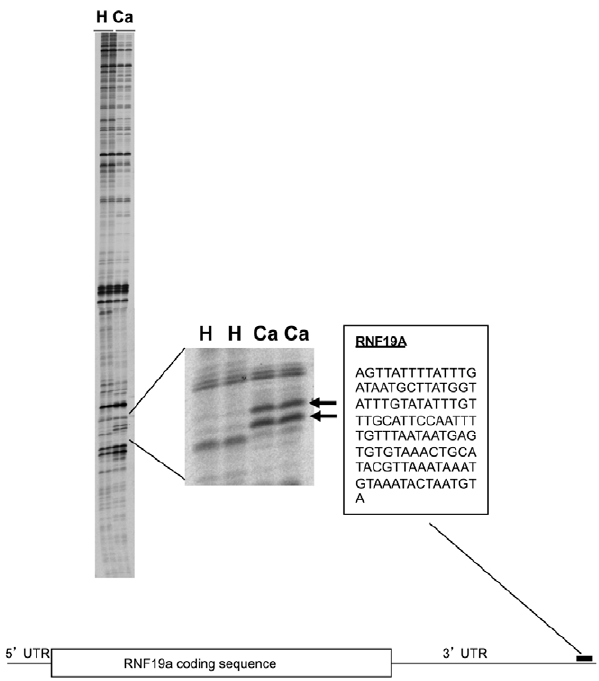
Figure 1. ADE analysis of whole blood RNA from prostate cancer patients vs. healthy men. ADE analysis identified two RNA transcripts with levels significantly higher in whole blood RNA from prostate cancer patients (Ca) than in healthy men (H). Nucleotide sequence analysis revealed that these two transcripts shared a common sequence. This sequence had 100% homology to the nucleotide sequence in the E3-ubiquitin ligase Ring Finger Protein 19a (RNF19A) transcript and is located in the 3 9 untranslated region (UTR).